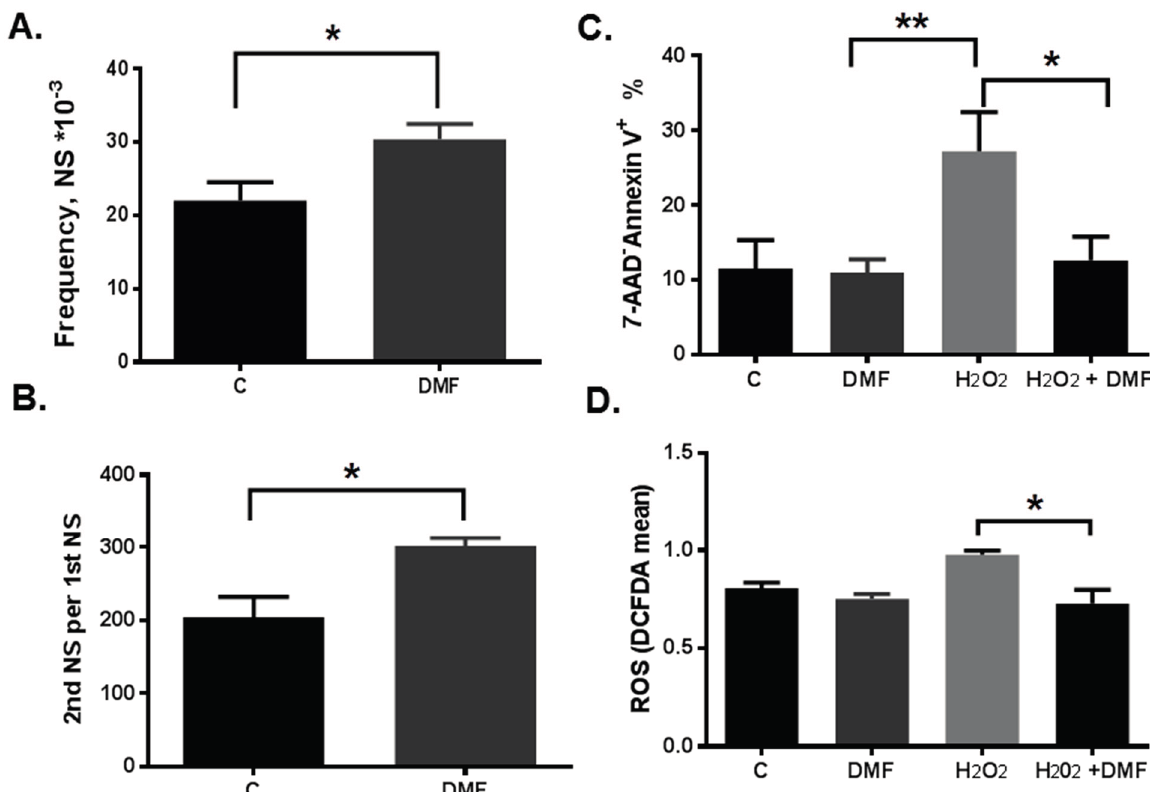
Figure 1. Dimethyl fumarate (DMF) increased self-renewal and reduced oxidative stress-induced apoptosis and ROS levels in neural stem/progenitor cells (NPCs). ( A ) Frequency of mouse neuronal stem/progenitor cells was calculated by dividing the number of neurospheres in the well by the number of plated cells with (DMF) or without (C) DMF treatment (Mean ± SEM were determined from seven replicate samples, * p = 0.027); ( B ) Self-renewal potential of mouse NPCs was calculated as number of secondary (2nd) neurospheres (NS) clonally derived from one primary (1st) neurosphere plated with (DMF) or without (C) DMF treatment (Mean ± SEM were determined from three replicate samples, * p = 0.03); ( C ) Rat NPCs were grown in adherent cultures in self-renewal medium. After treatment under indicated conditions with control (C), DMF alone (DMF) for overnight, then H 2 O 2 alone (H 2 O 2 ) and DMF together with H 2 O 2 (H 2 O 2 + DMF) for another 6 h, the NPC cells were trypsinized, then apoptosis assay was performed as described under “Material and methods”. Mean ± SEM were determined from three replicatesamples, * p = 0.015, ** p = 0.007); ( D ) Cells treated same as in “C” and then incubated with 5 µM 2 ′ ,7 ′ -dichlorofluorescein diacetate (DCFDA) for 15 min at 37 °C and oxidative stress was measured as ROS binding to DCFDA and quantified by flow cytometry. Mean ± SEM were determined from three replicate samples, * p =